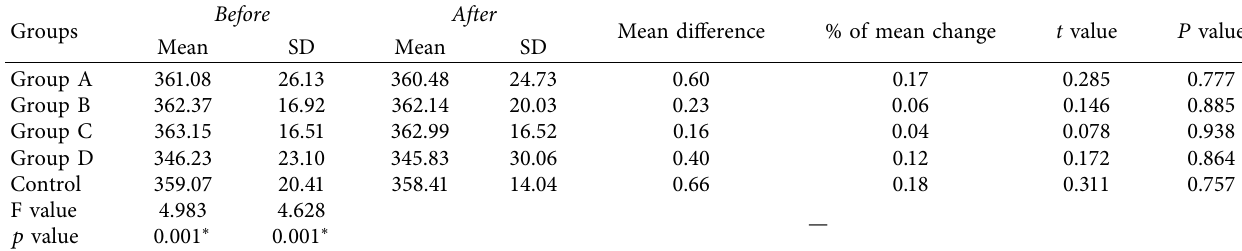
Table 5: Right side masseter muscle amplitude before and after treatment.